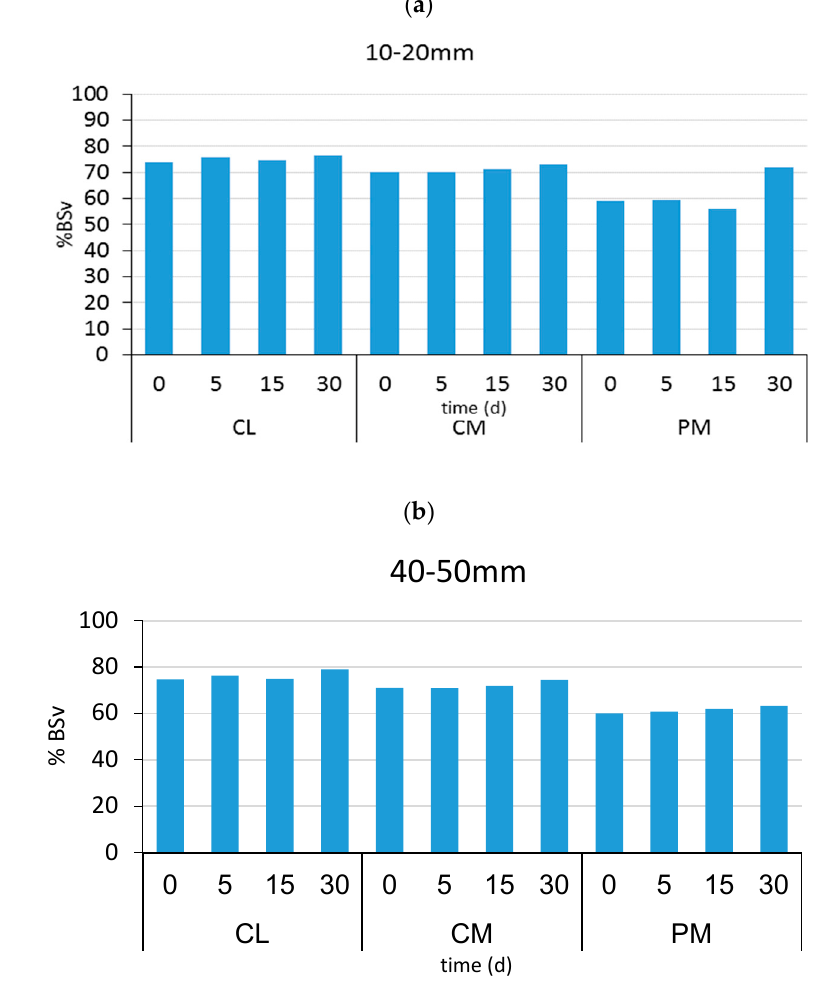
Figure 3. Backscattering profiles vs. sample tube height: ( a ) 10–20 mm and ( b ) 40–50 mm. Average values ( n = 2). Std. deviation <